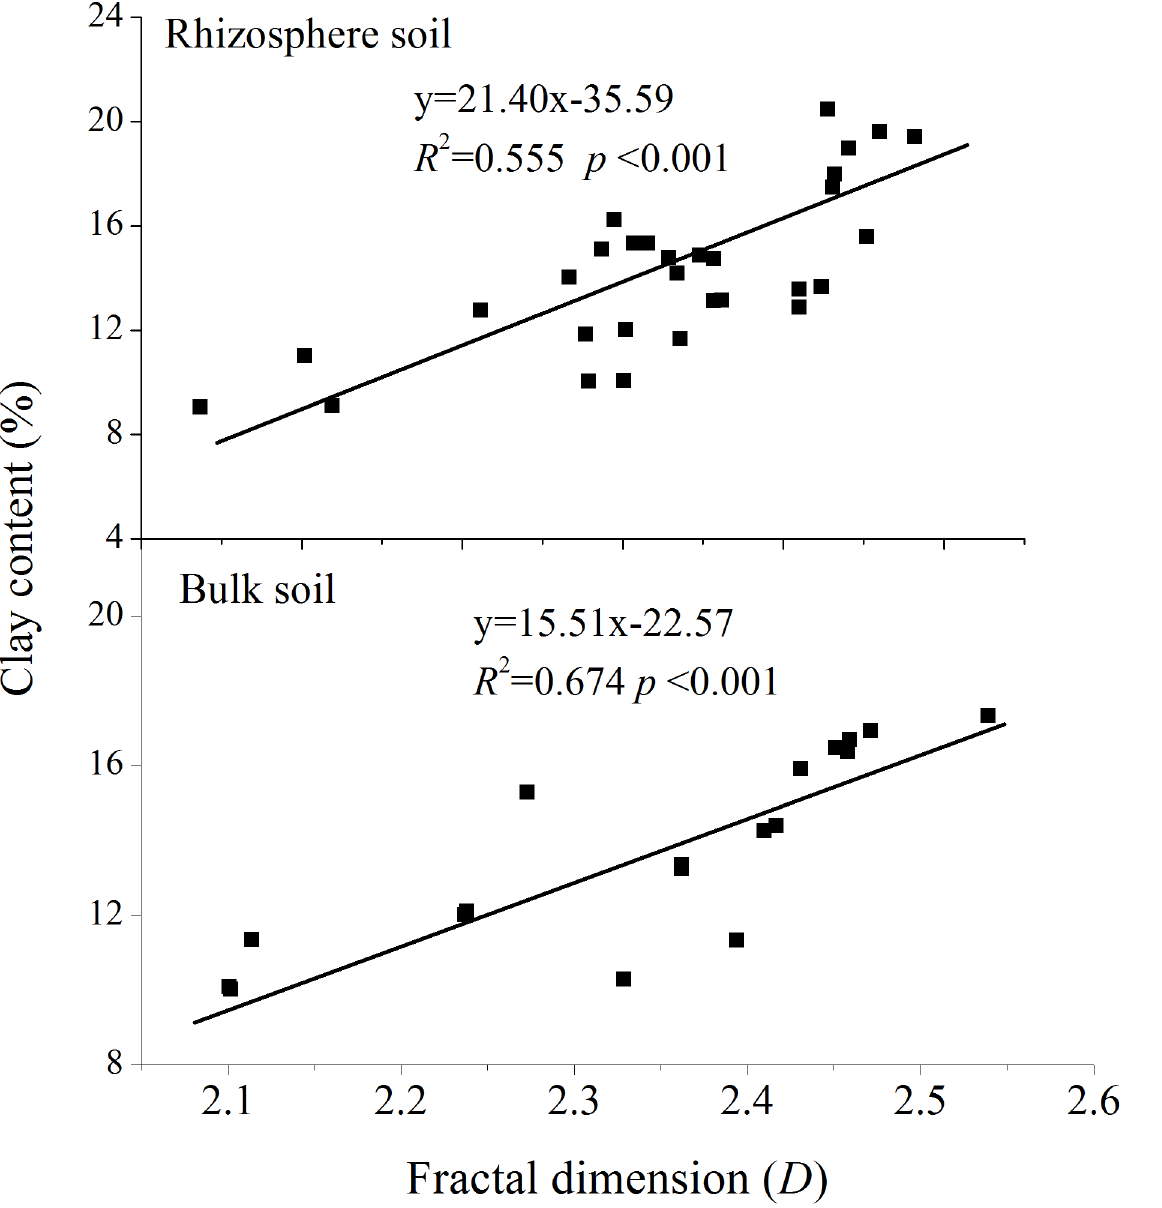
Fig 3. Relationships between fractal dimension and soil clay